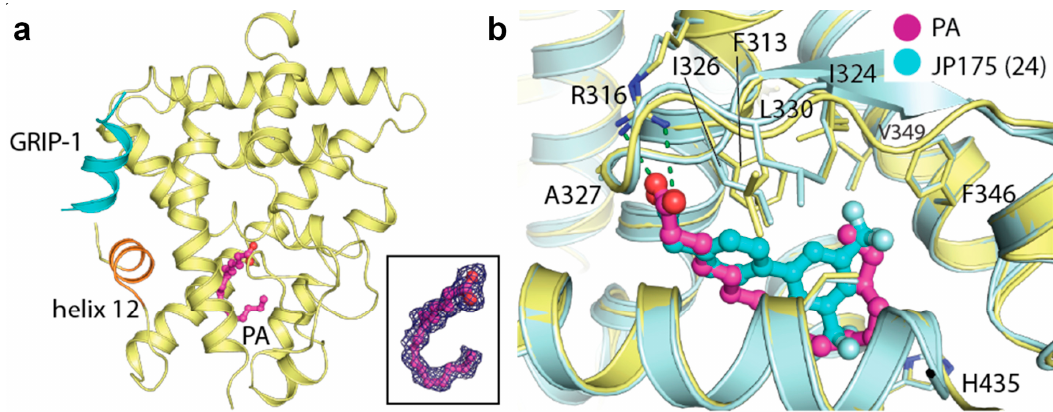
Figure 1. Palmitic acid binding to retinoid X receptor α (RXR α ). ( a ) Overview of the crystal structure of the tertiary complex between RXR α , palmitic acid (PA; magenta sticks) and glucocorticoid receptor interacting protein 1 (GRIP-1) activating peptide (blue). Inset shows |F O |-|F C | omitted electron density map contoured at 3 σ for the bound fatty acid. ( b ) Superimposition of the JP175- and PA-complexed RXR α structures reveals that PA occupies the same space in the binding pocket as the small molecule modulator with no structural alteration observed upon its binding.